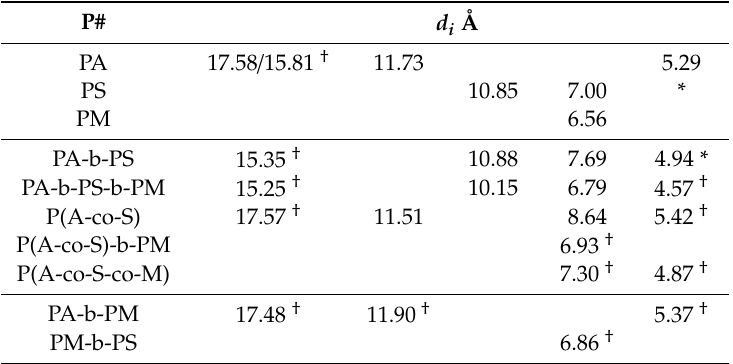
* —Growing peak at wider angles (2θ > 20 o ) . † — Measured by XRD.